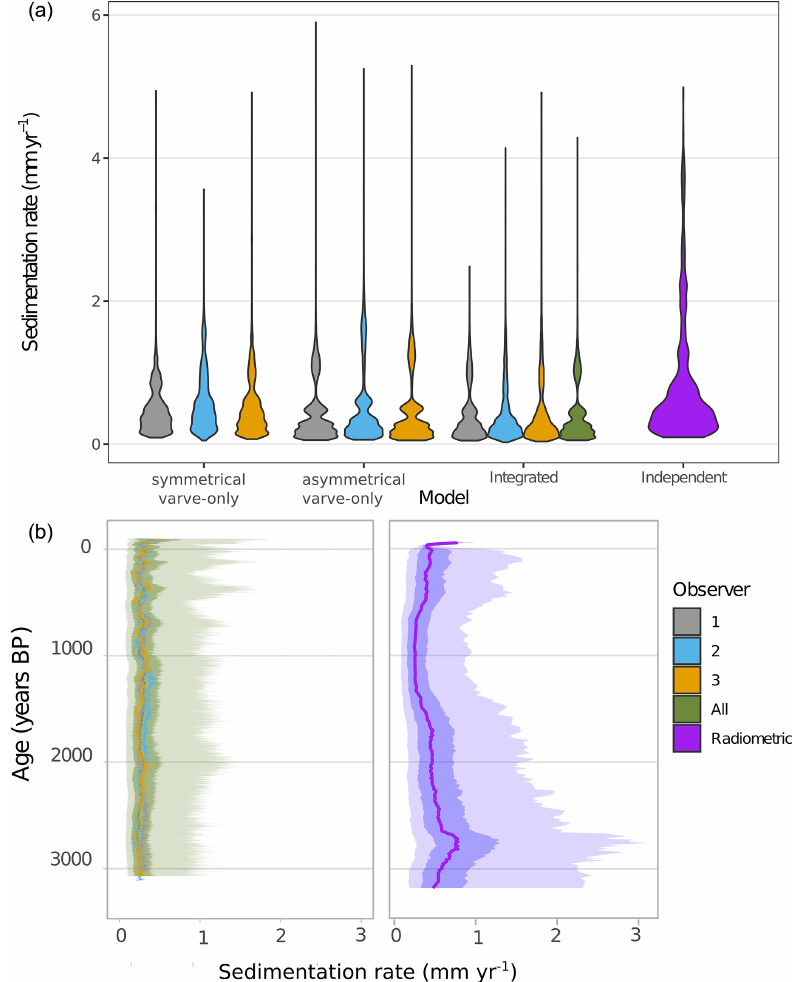
Figure 9. Comparison of sedimentation rates. (a) Summary of sedimentation rates calculated with different models and separated by ob- server. In green, the multiple observer integrated model (MOIM) is labeled “all”. (b) Late Holocene median (thick lines), 75% (darker shading), and 97.5% (lighter shading) highest probability density region estimates of sedimentation rates calculated by the integrated (left) and radiometric (right) models for the dated core COL17-3. Note that the medians for each observer are plotted in the left panel (thick